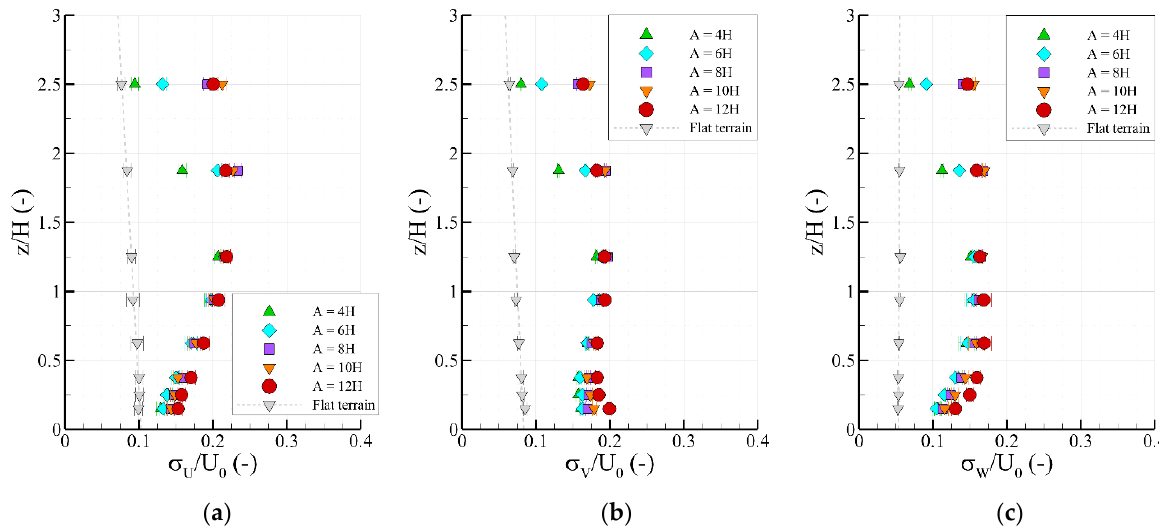
Figure 9. Vertical profiles of the normalized longitudinal ( a ), lateral ( b ), and vertical ( c ) velocity fluctuations at a longitudinal distance of X = 2H downwind from the valleys.